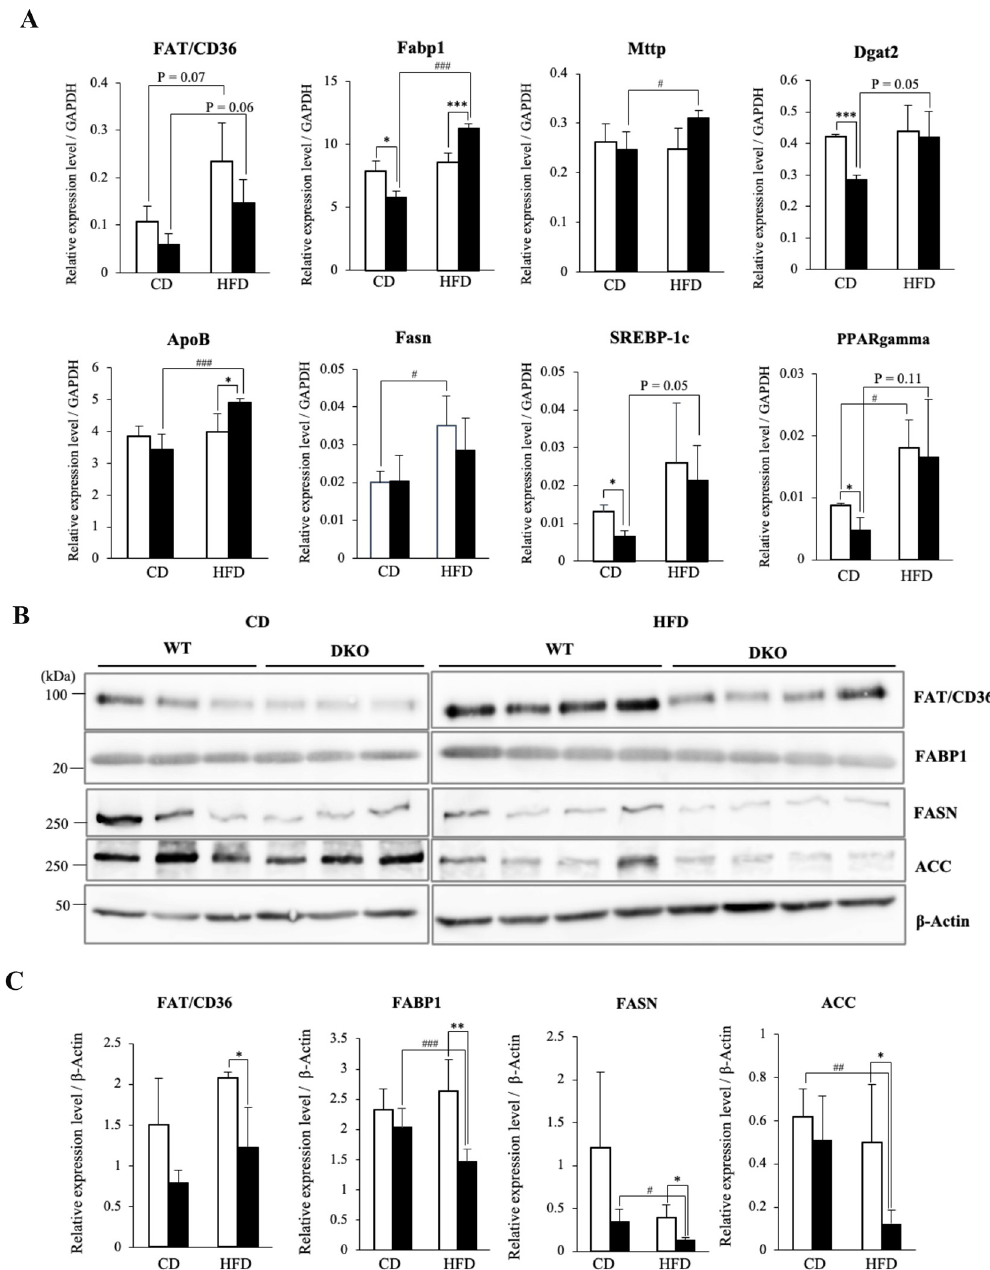
Fig 4. Expressions levels of hepatic lipogenesis-related molecules were lower in HFD-fed DKO mice than in WT mice. ( A ) mRNA levels of lipid metabolism-related genes in livers of CD-fed or HFD-fed mice were analyzed by real-time RT-PCR, and are presented after correction with the GAPDH gene. Open and closed bars indicate WT and DKO mice, respectively. The numbers of mice examined were WT, n = 3; DKO, n = 3 in individual diet groups. Data are expressed as means ± S.D. � P < 0.05 and ��� P < 0.001 as compared between WT and DKO mice. # P < 0.05 and ### P < 0.001 as compared between CD and HFD groups. ( B ) Protein levels of lipid metabolism-related molecules in livers of CD-fed (3 each) or HFD- fed (4 each) mice were analyzed by immunoblotting. ( C ) Relative expression levels are presented by measuring band intensities in (B) after correction with those of β -Actin. Open and closed bars indicate WT and DKO mice, respectively. Data are expressed as means ± S.D. � P < 0.05 and �� P < 0.01 as compared between WT and DKO mice. # P < 0.05, ## P < 0.01 and ### P < 0.001 as compared between CD and HFD